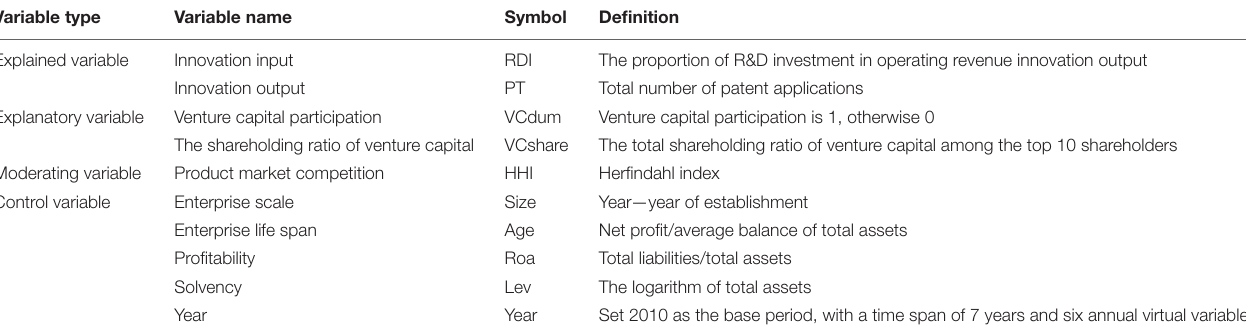
TABLE 2 | Specific definitions of various variables.